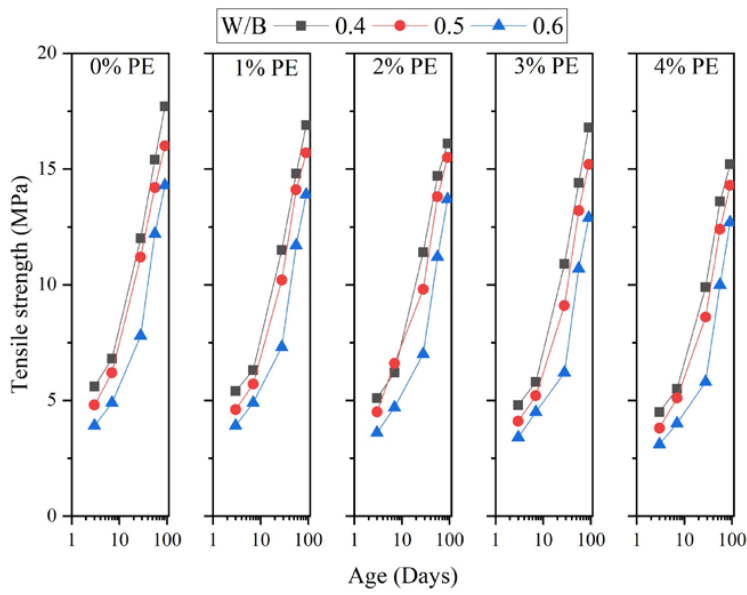
Figure 7. Tensile strength of cement mortar with different W/B ratios and waste PE. At the age of 56 days, when the W/B ratio is 0.5, the GGBFS content is 20% and the tensile strength is 14.2~12.4 MPa for a waste PE content of 0~4%, indicating that the tensile strength is slightly decreased with the increased waste PE content; at the age of 91 days, the tensile strength is 16~14.3 MPa. As the waste PE is soft and the tensile strength cannot be effectively increased, the tensile strength is decreased with increasing waste PE content. Meanwhile, the tensile strength, flexural strength, and compressive strength show the same trend. 3.7. Ultrasonic Pulse Velocity As shown in Figure 8, at the age of 28 days, with a W/B ratio of 0.4, GGBFS of 20%, and different percentages of waste PE, the ultrasonic pulse velocity is 4720~4501 m/s; the pulse velocity is 4386~4173 m/s for a W/B ratio of 0.5, which is reduced by 7.1~7.4% in comparison to that at a W/B ratio of 0.4; when the W/B ratio is 0.6, the pulse velocity is 3825~3611 m/s, which is reduced by 12.8~13.5% in comparison to that at a W/B ratio of 0.5, meaning that the ultrasonic pulse velocity is decreased with increasing W/B ratio. At the age of 91 days, the control group shows a better ultrasonic pulse velocity of 4903 m/s; the ultrasonic pulse velocity is 4816 m/s for a waste PE content of 1%; and the ultrasonic pulse velocity is decreased to 4607 m/s for a waste PE content of 4%, which represents a 6.1% reduction in comparison to that for the control group. At the age of 56 days, when the substitution amount of GGBFS is 20% and the waste PE fiber material